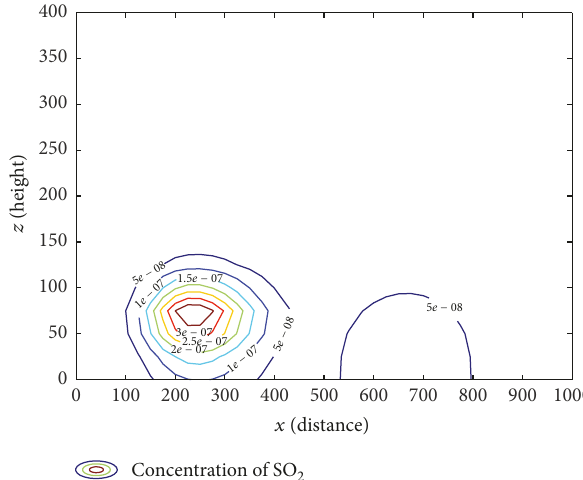
Figure 5: The concentration of air pollution with the different monitoring point at 𝑧 = 50 m without control system.